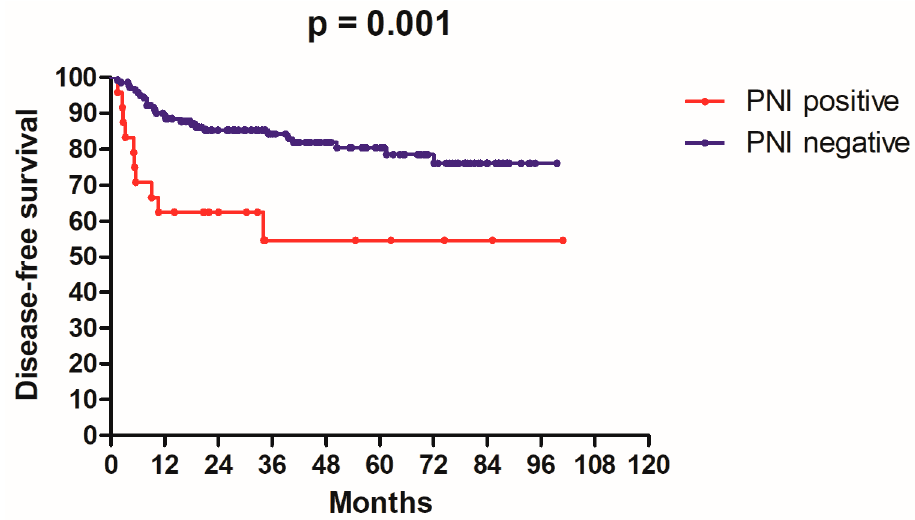
Figure 2. Kaplan–Meier disease-free survival curve according to peri-neural invasion status in 166 patients with T2N0